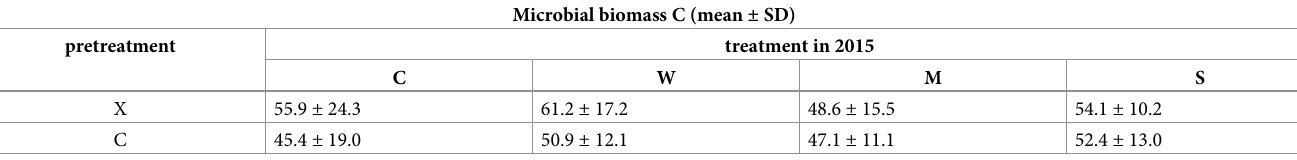
Comparison of activity density difference (ADD) percentages before and after treatment for epedaphic Collembola. Z-test, 2015 data. Percentage data were derived from